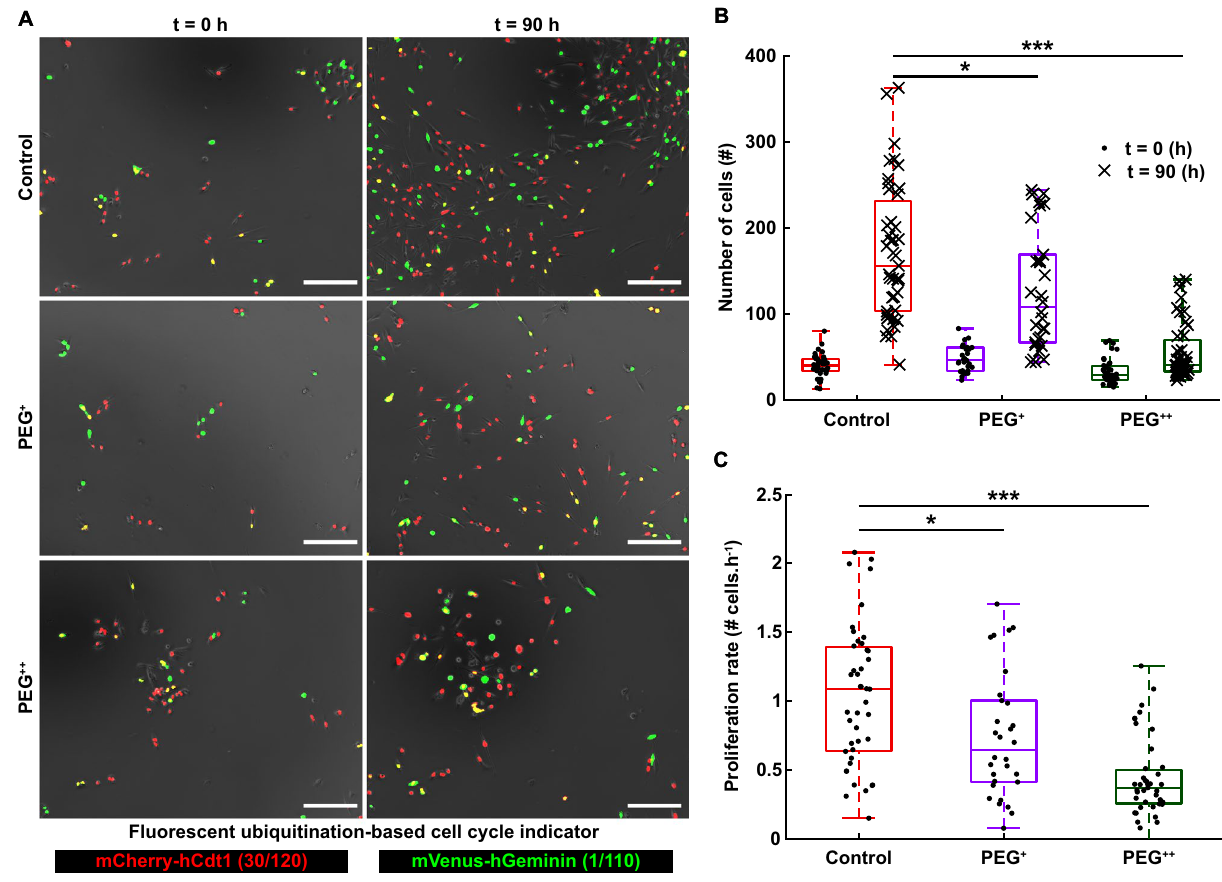
Figure 1. Increase of osmotic pressure slows down the cell cycle dynamics in a concentration-dependent fashion. ( A ) Time-lapse of MDA-FUCCI2 cells exposed to three different osmolalities: 320 mOsm kg −1 (control), 380 mOsm kg −1 (PEG + ) and 460 mOsm kg −1 (PEG ++ ). Scale bars are 200 µm. ( B ) Number of cells at time 0 and after 90 h of imaging (5 biological repeats and N = 43, 30 and 43 number of wells for the control, PEG + and PEG ++ groups, respectively). ( C ) Proliferation rates are taken as the slopes of the curves indicating the number of cells as a function of time (Supplementary Fig. S1), in the range between 0 and 30 h. The plots represent the median, 1st and 3rd quartiles and extrema. Statistical analysis with respect to the control using a two-tailed Wilcoxon rank sum test, n.s: p > 0.05, *: p < 0.05, **: p < 0.01 and ***: p <